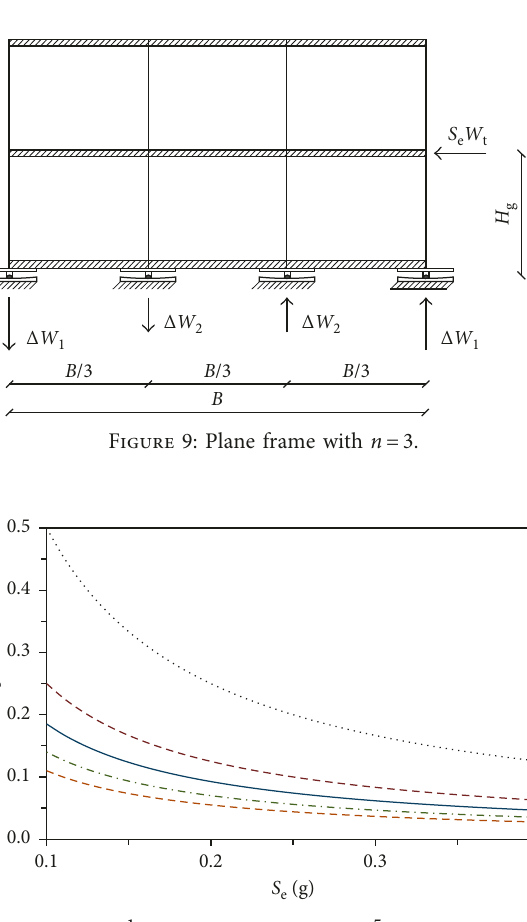
increased (cid:31)